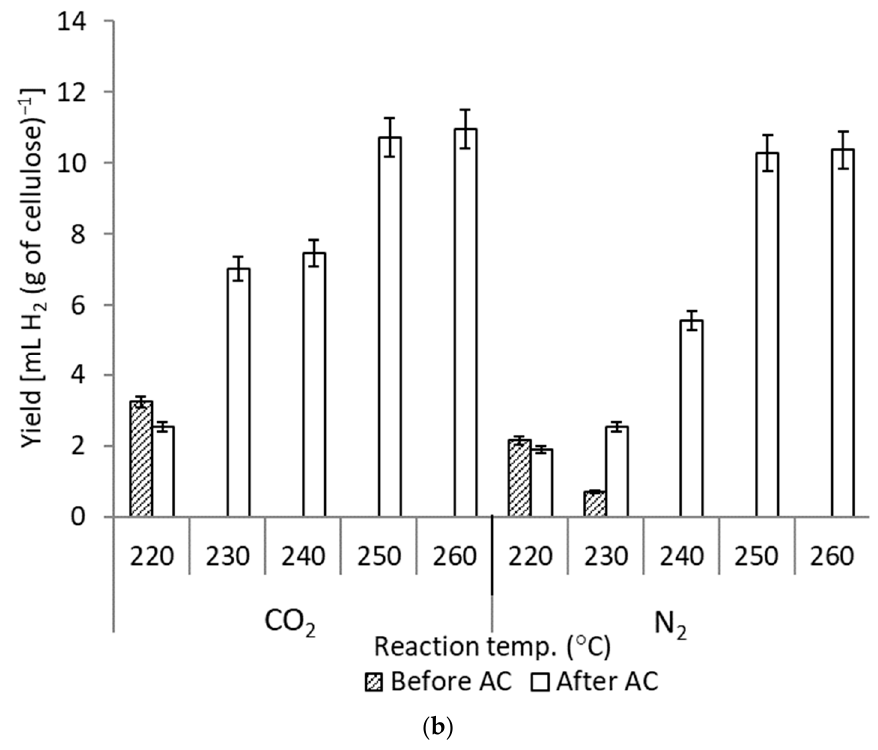
Figure 5. ( a ) Growth of E. coli in hydrolysates prepared under CO 2 at different reaction temperatures ( ● ) without and ( ○ ) with AC treatment. The dotted line represents the biomass yield from the glucose control (20 mM); ( b ) Hydrogen yields after fermentation of the hydrolysates produced at various temperatures. Under CO 2 no H 2 was produced before AC treatment from samples prepared at temperatures higher than 230 °C; under N 2 no H 2 was produced from samples prepared at above 240 °C before AC treatment. At 220 °C the concentration of 5-HMF in the hydrolysate is too low to cause total inhibition and H 2 is produced. As temperature increases, and the concentration of 5-HMF increases, the inhibitory effect is evident.